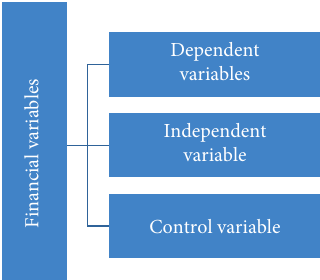
Figure 9: The general trend of optimization of the stochastic capital